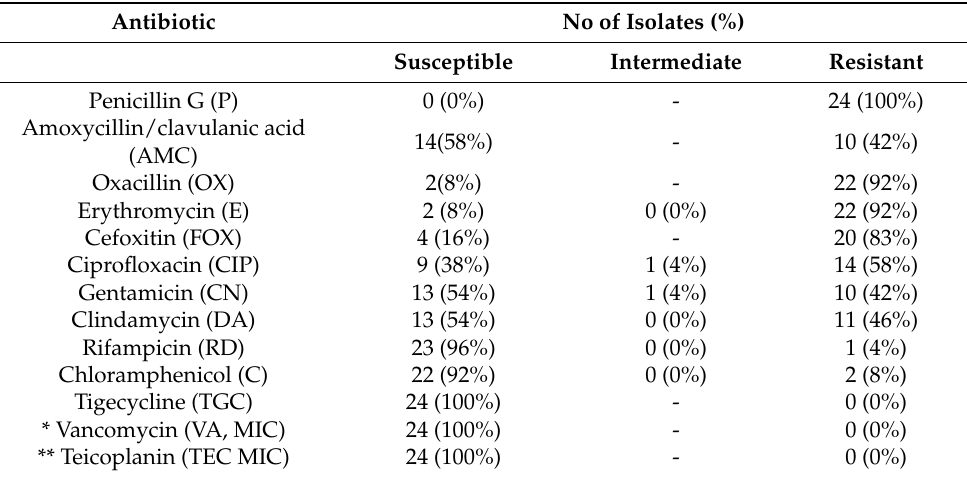
Table 2. Minimum inhibitory concentrations (MIC) of S. epidermidis isolates were determined using the disc diffusion method. The number of isolates that are susceptible, intermediate, or resistant are shown with the percentages in brackets. Broth microdilution methods were used for vancomycin and teicoplanin MICs. Interpretive categories and zone diameter breakpoints were determined according to